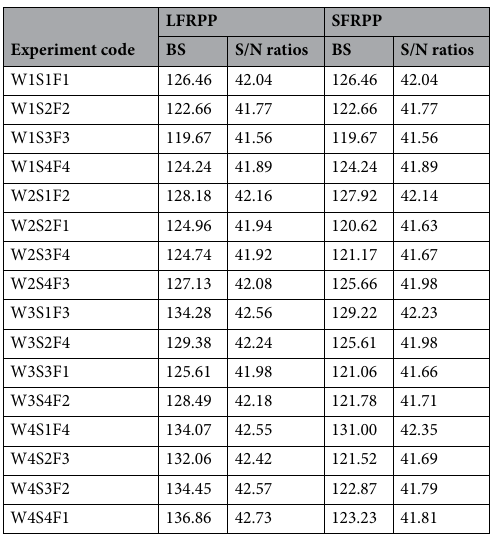
Table 7. Design and experimental results of the L16 orthogonal array.